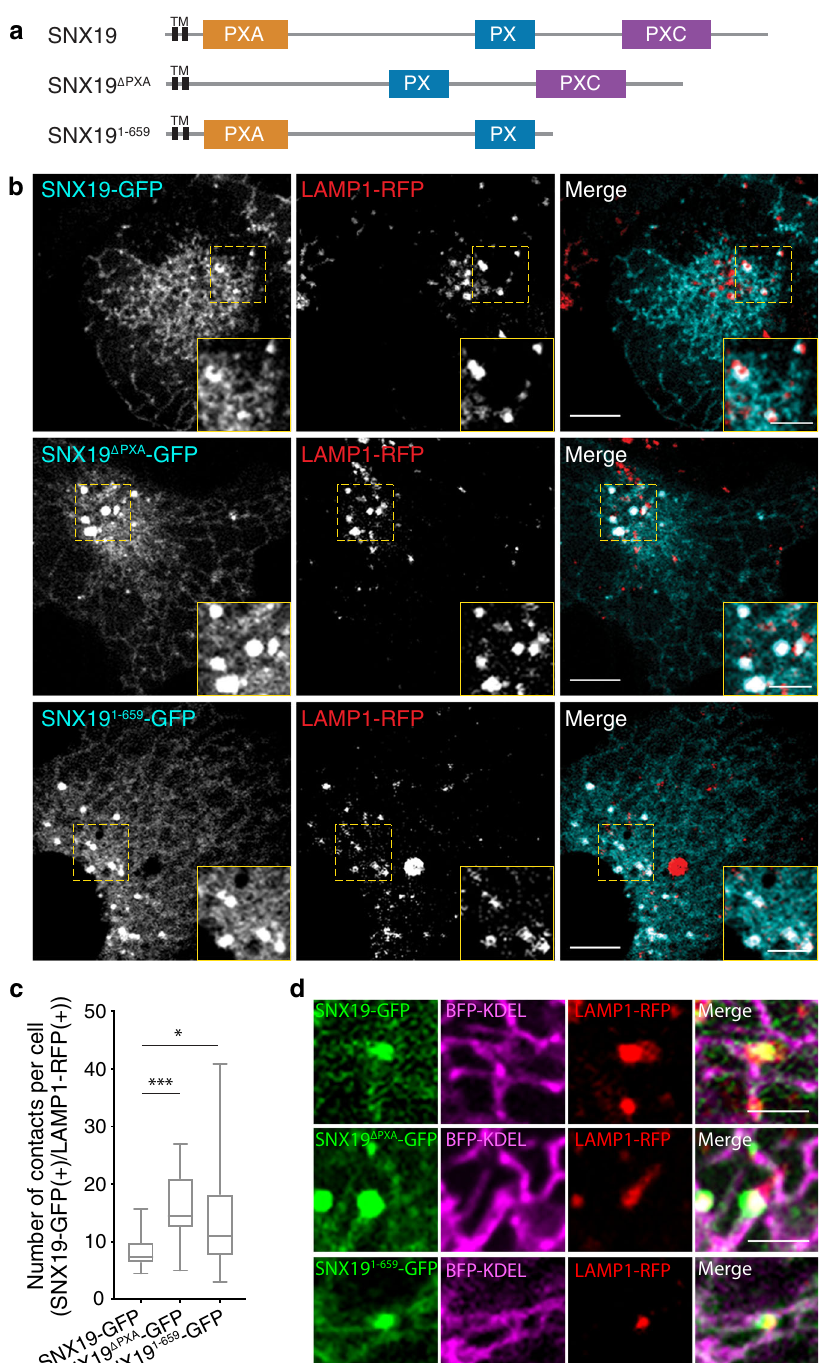
Fig. 3 Deletion of SNX19 PXA or PXC domains results in hypertethering to endolysosomes. a Scheme of WT SNX19 and SNX19 mutants lacking the PXA domain or the C-terminal region containing the PXC domain. Scheme not to scale. b U-2 OS cells were co-transfected with plasmids encoding GFP-tagged SNX19 constructs depicted in a together with LAMP1-RFP, and imaged live by confocal microscopy. Insets are zoomed-in areas of dashed boxes. c Quanti fi cation of the number of contacts between SNX19-GFP constructs and LAMP1-RFP observed under conditions in b . The data are represented as box and whisker plot with the box extending from 25th to 75th percentiles, the horizontal line representing the median, and the whiskers representing the minimum and maximum values. Data is from n = 3 independent experiments, where 10 – 20 cells were quanti fi ed per condition, per experiment. Signi fi cance was computed by Kruskal – Wallis one-way ANOVA; * p = 0.0217, *** p <0.001. Source data are provided as a Source Data fi le. d U-2 OS cells were co-transfected with plasmids encoding BFP-KDEL, LAMP1- RFP, and each of the GFP-tagged SNX19 constructs depicted in a , and cells were imaged live by confocal microscopy. Images show close-up SNX19-GFP – EL contacts. Experiment was independently conducted at least three times and was reproducible. Scale bars: 10 μ m in b , 5 μ m insets and in d